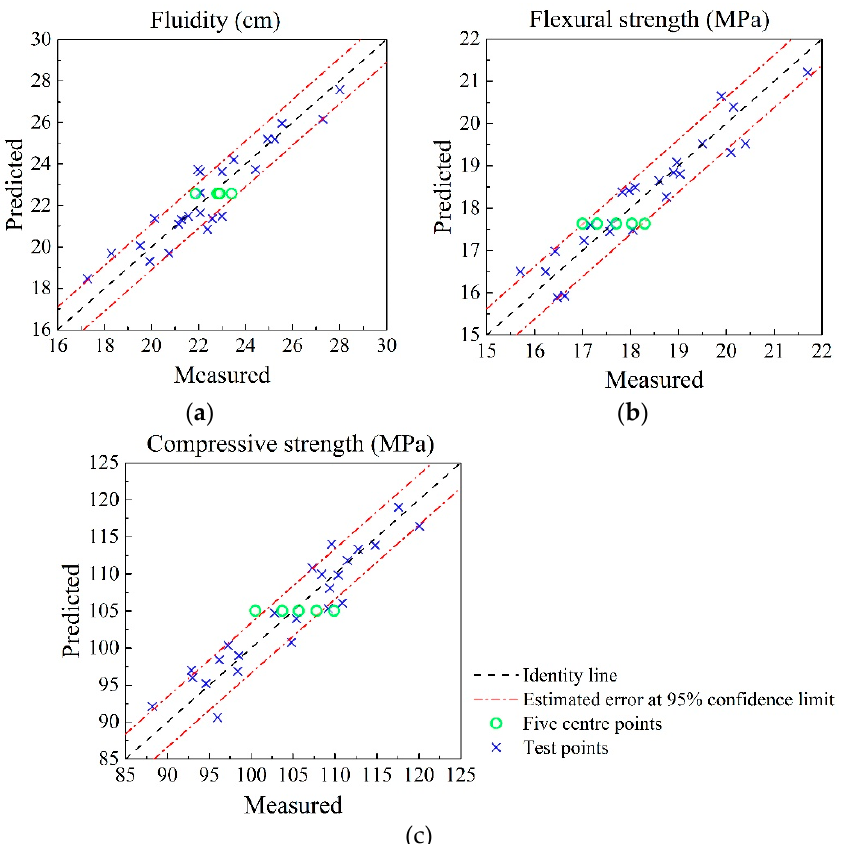
Figure 2. Predicted and measured values of experimental properties. ( a ) Fluidity; ( b ) flexural strength and ( c ) compressive strength.